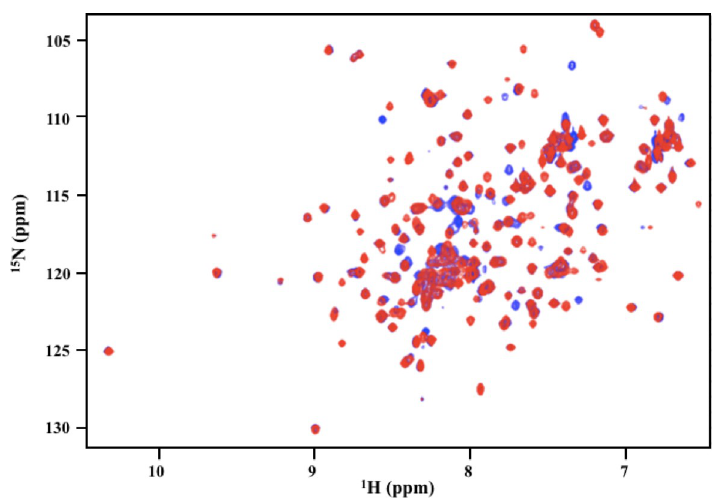
Fig 5. The tertiary structures of p58C 272-464 and p58C 266-464 constructs are similar in solution. 15 N- 1 H HSQC NMR spectra of p58C 272-464 (blue) and p58C 266-464 (red) were acquired at 25˚C on a Bruker AV-III spectrometer operating at 800 MHz. The samples contained 200 μ M protein in a buffer containing 20 mM MES (pH 6.5), 50 mM NaCl, 2 mM DTT, and 5% 2 H 2 O.